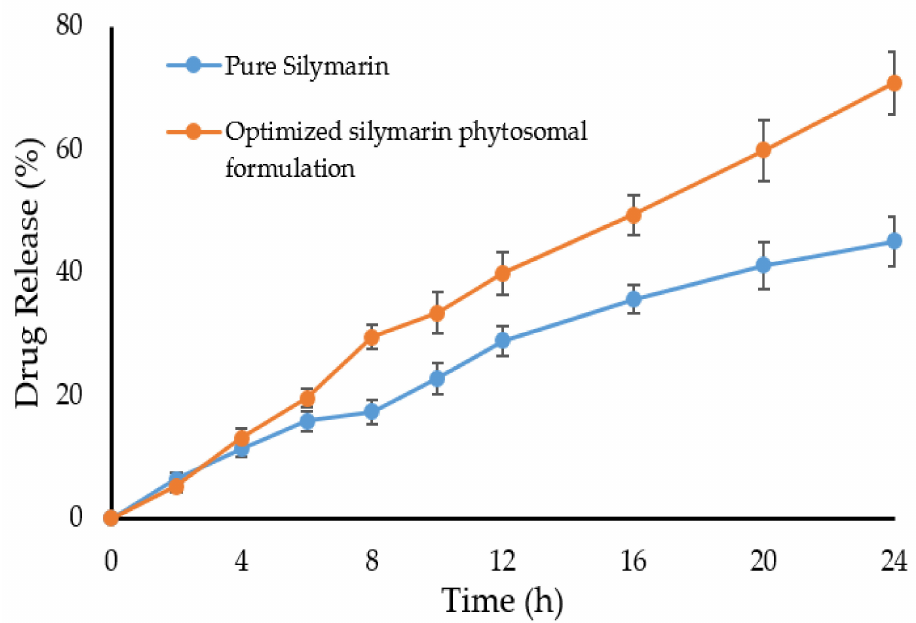
Figure 6. In vitro drug release profile of pure silymarin and optimized silymarin phytosomal formu- lation in phosphate buffer pH 7.4. Values are mean ± SD ( n =